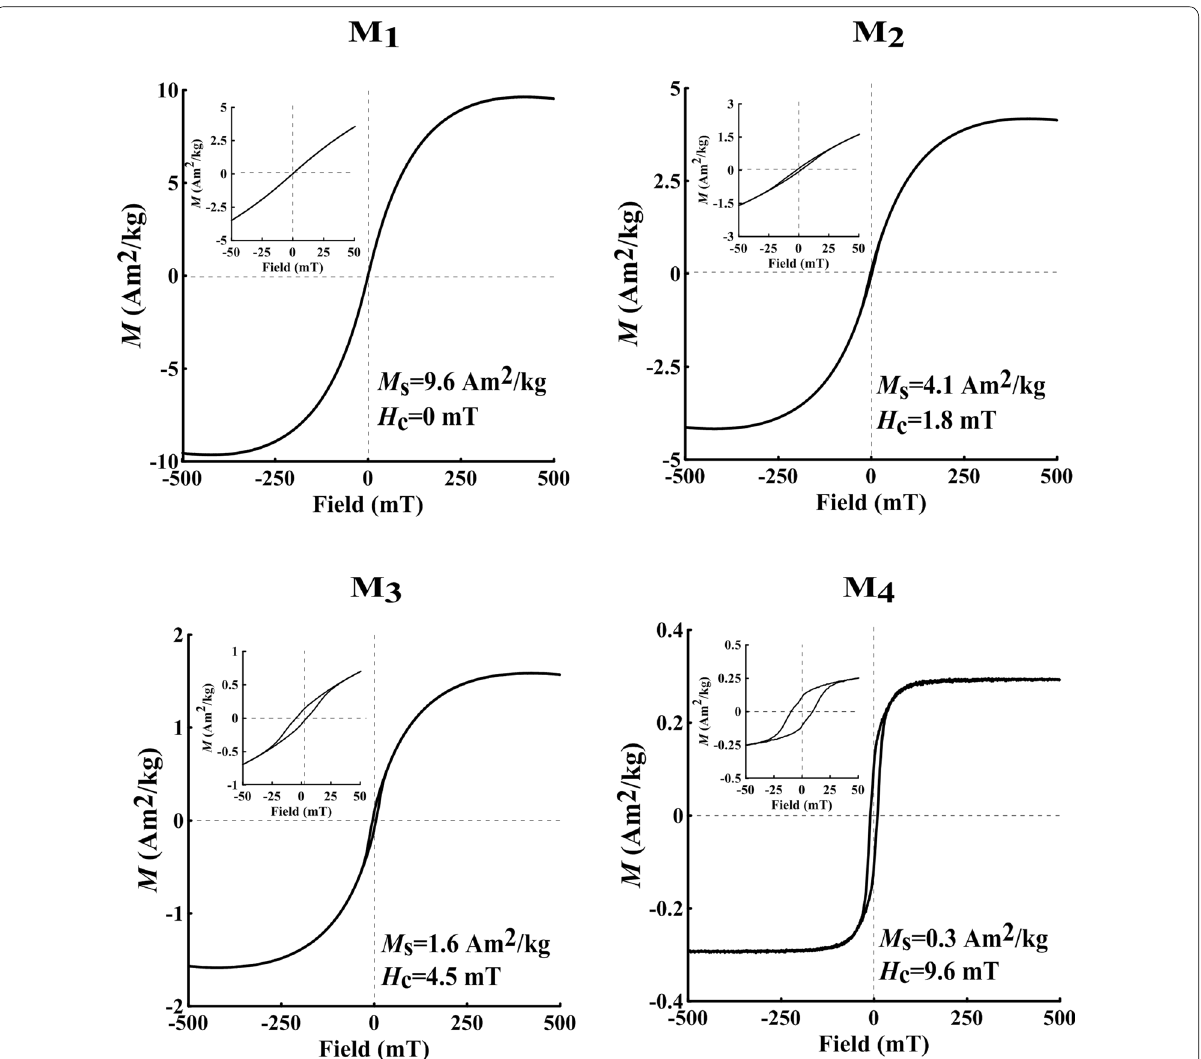
Fig. 3 Hysteresis loops of four samples measured at room